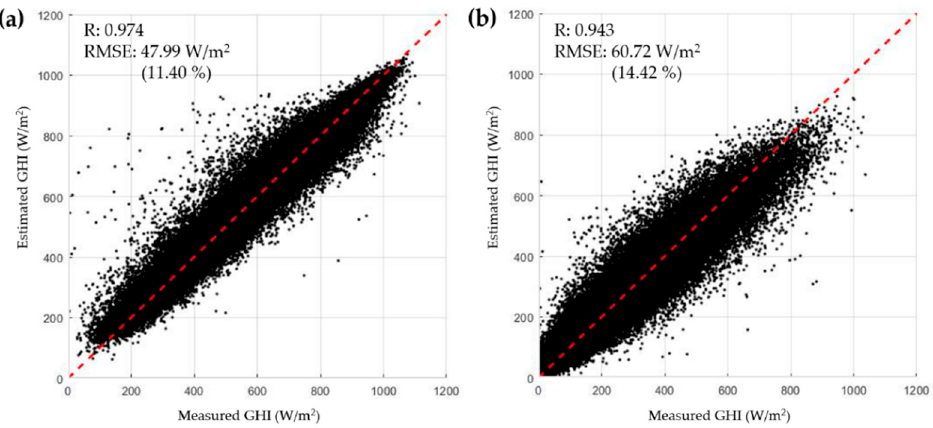
Figure 11. Scatter plots of measured GHI and estimated GHI for ( a ) a clear sky, ( b ) a cloudy sky.